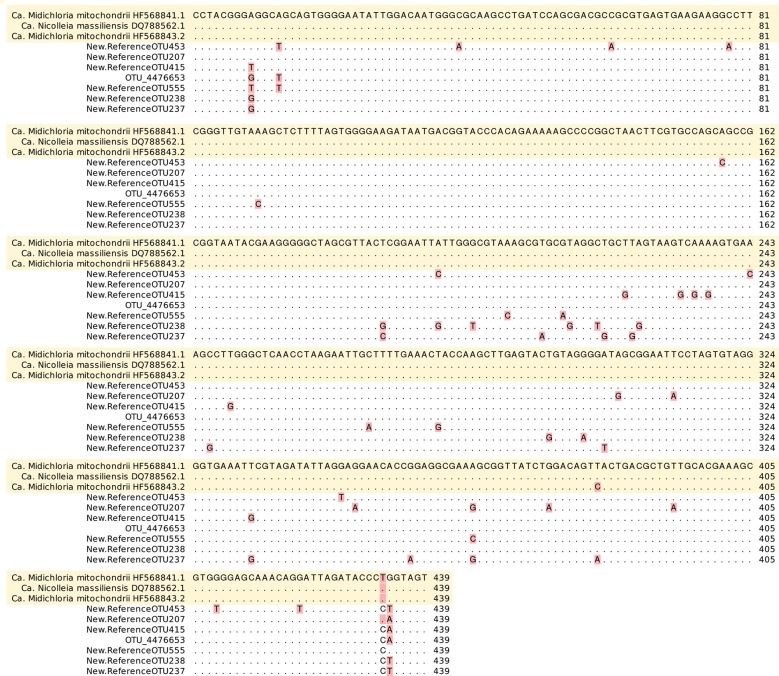
Nucleotide alignment of ‘Candidatus Midichloriaceae’ partial 16S rRNA references (according to BLAST) versus closed undefined OTUs (according to Greengenes database).